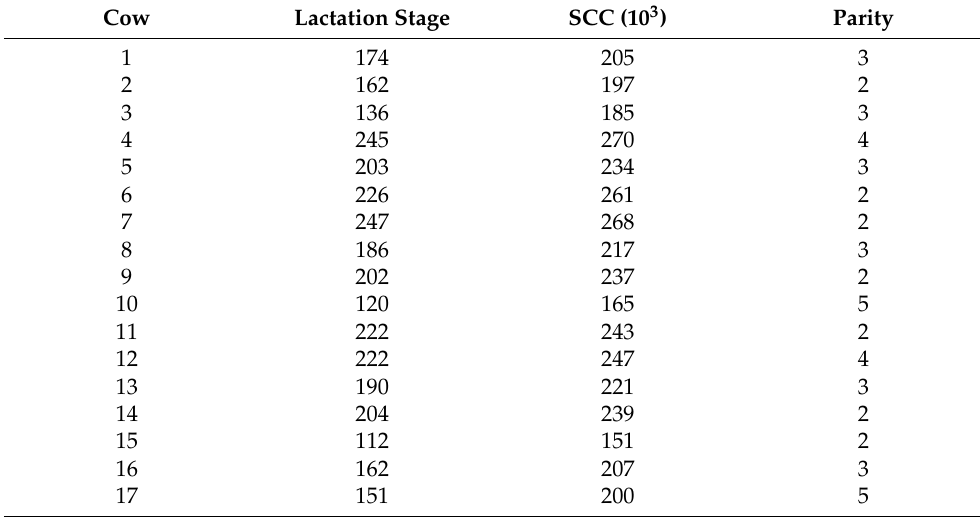
Table 2. Description of cows from Sample Set 2 (lactation days, somatic cell count (SCC), and parity). Cow Lactation Stage SCC (10 3